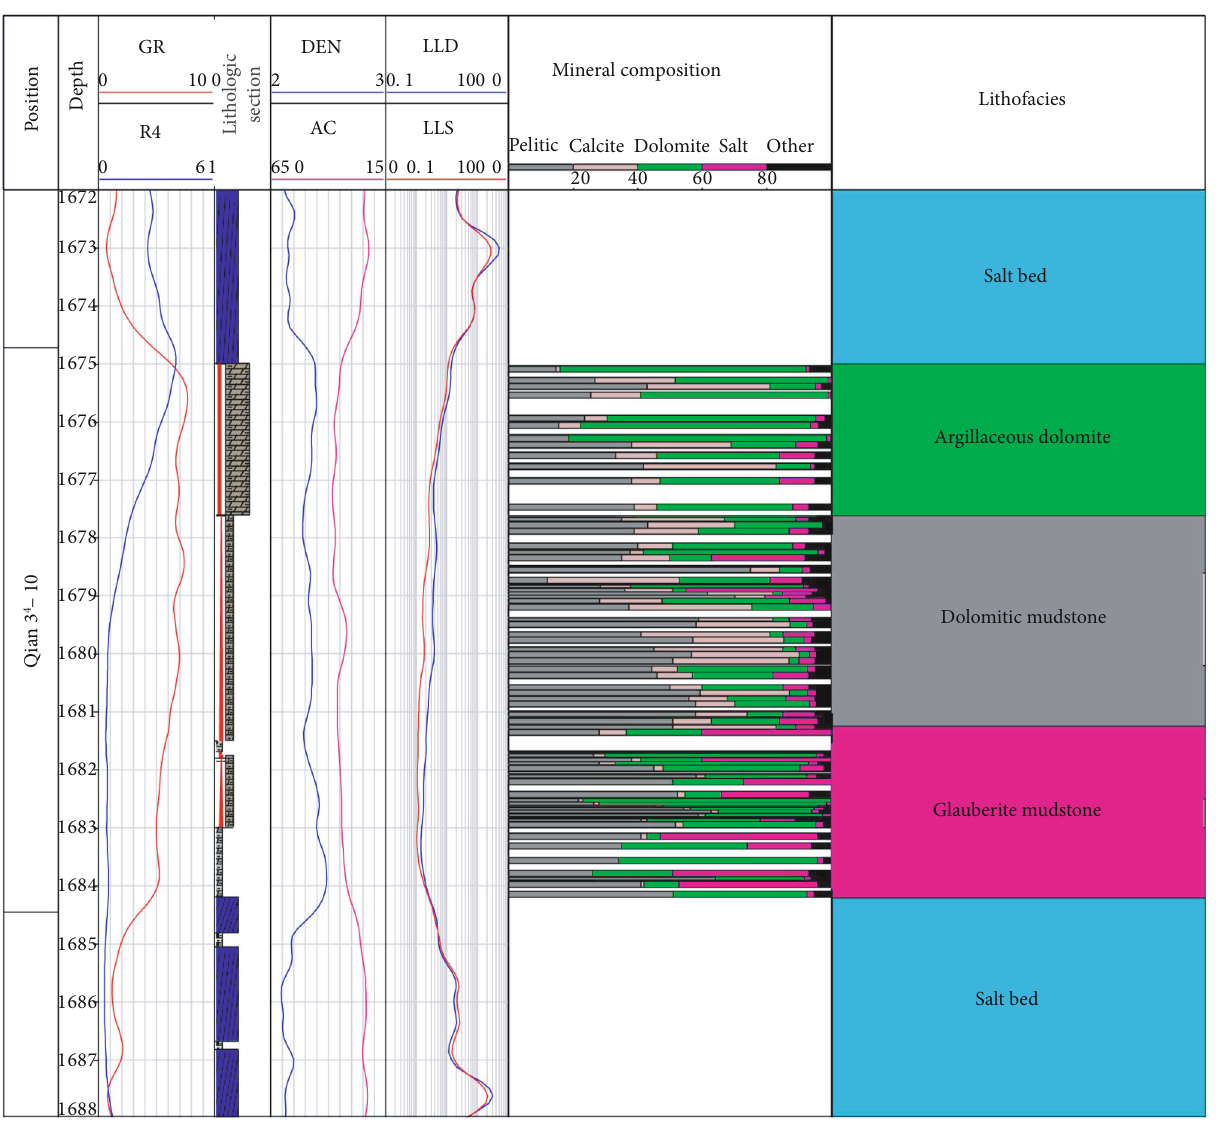
Figure 1: Sedimentary facies histogram of Qian 3 4 -10 cyclothem in the intersalt dolomite shale reservoir.